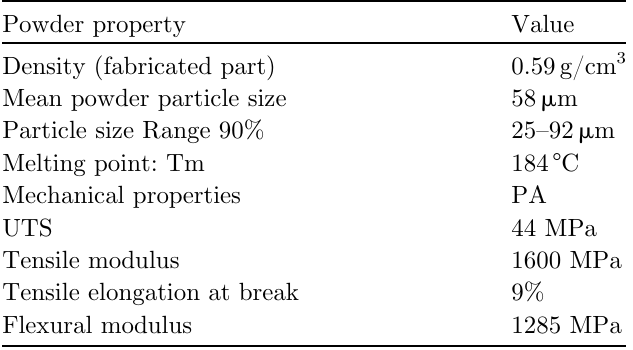
Table 1. Property of DuraForm ProX PA [31].